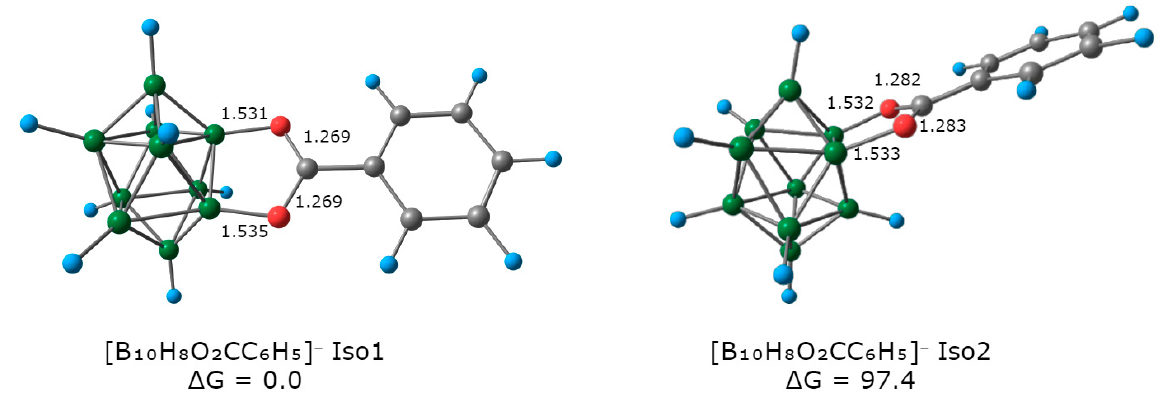
Figure 7. The structure of main isomers of the [B 10 H 8 O 2 CC 6 H 5 ] − anion. Length units—Å; energy units—kJ/mol; ω B97X-D3/def2-TZVPP level of theory.